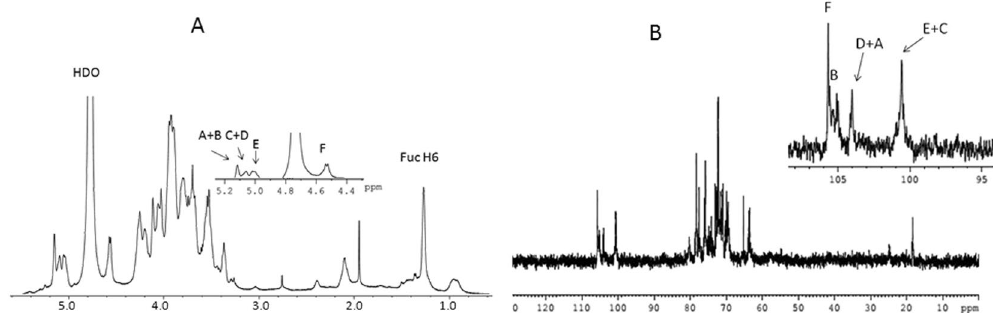
Figure 1. 500 MHz 1 H NMR and 125 MHz 13 C NMR spectrum of FVPB2 polysaccharide in deuterium oxide (D 2 O) at 27 °C. The anomeric protons are labeled as ( A – F ). ( A) . 500 MHz 1 H NMR spectrum of FVPB2 polysaccharide in D 2 O at 27 °C. The anomeric protons are labeled as ( A – F ). ( B ) 125 MHz 13 C NMR spectrum of FVPB2 polysaccharide in D 2 O at 27